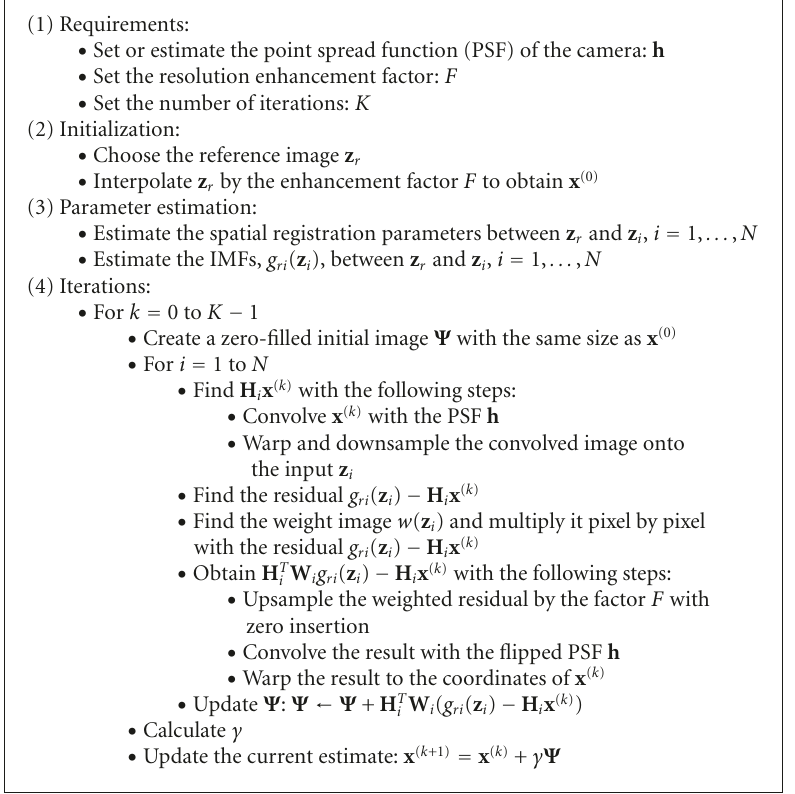
Algorithm 1: Pseudocode of the spatial enhancement algorithm.